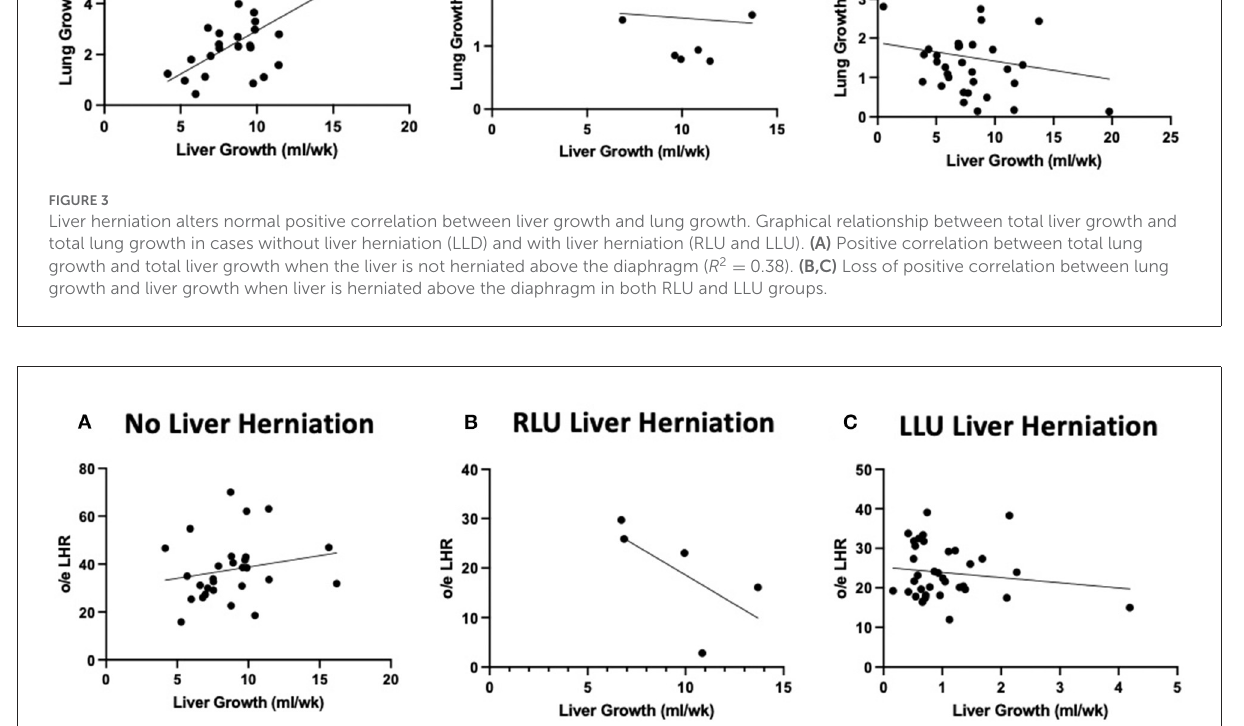
FIGURE4 Liver growth correlations to o/e LHR in both herniated and non herniated groups. Graphical relationship between total liver growth and o/e LHR in cases without liver herniation (LLD) and with liver herniation (RLU and LLU). (A) No correlation between total o/e LHR and total liver growth when the liver is not herniated above the diaphragm. (B) A negative correlation between o/e LHR and liver growth when liver is herniated above the diaphragm in RLU group (R 2 = 0.42). (C) No correlation between o/e LHR and liver growth when liver is herniated above the diaphragm in LLU